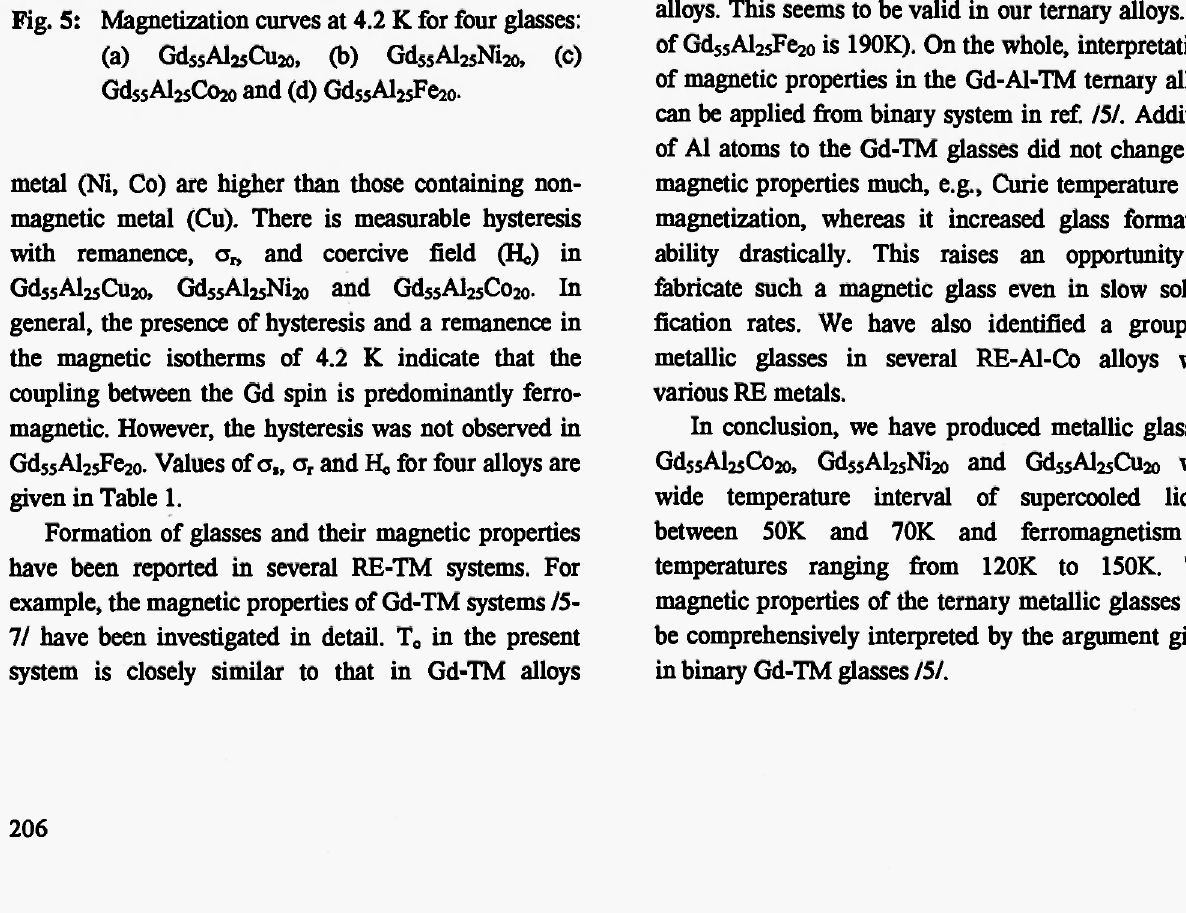
Fig. 5: Magnetization curves at 4.2 Κ for four glasses: (a) GdssAljjCuzo, (b) Gd GdssAlzsOho and (d)